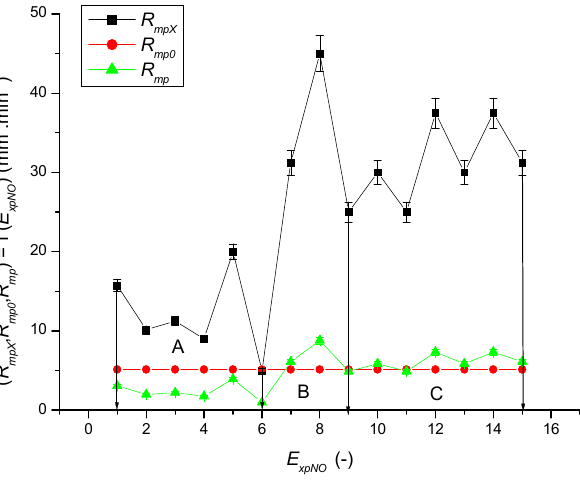
Figure 10. Graph of selected values of R mp , R mp0 and R mpX as the function ( E xpNo ) for NiCrBSI alloy.